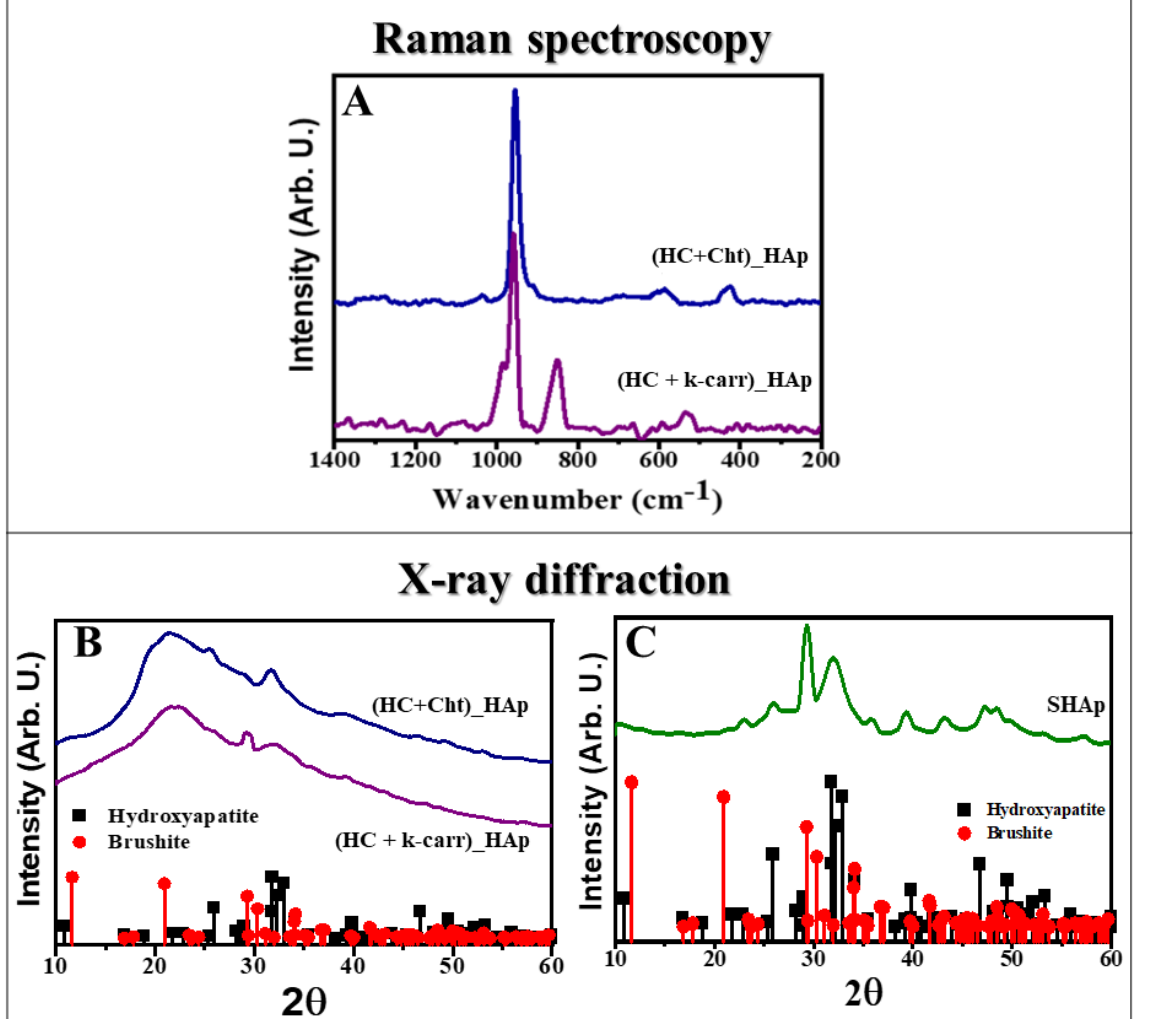
Figure 1. Structural characterization of the hybrid membranes. ( A ) Raman spectra of the biopolymeric membranes composed of hydrolyzed collagen (HC) and chitosan (Cht)—blue line or kappa—carrageenan ( κ —carr)—purple line after precipitation of the mineral phase by Methodology 1 (HAp). ( B ) X—ray diffraction pattern of the mineral phase precipitated in the presence and ( C ) in the absence of the biopolymeric matrix (SHAp). The mineral phase was identified by the diffraction patterns ( ■ ) 9011092—hexagonal hydroxyapatite and ( ● ) 1533075— monoclinic brushite from the Crystallography Open Database (COD).